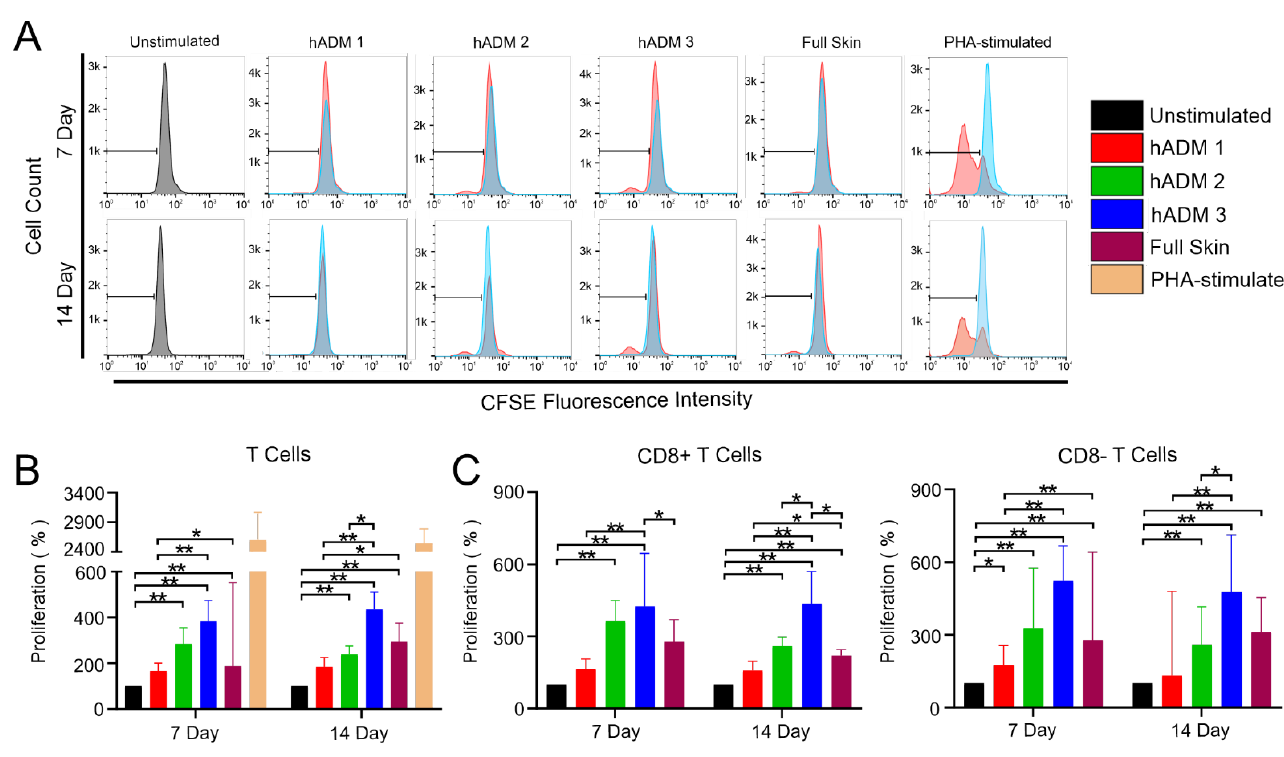
Figure 1. hADM preparation method induces differential T cell proliferation. Flow cytometric analysis of T cell proliferation. CFSE-stained PBMCs were co-incubated alone, with hADMs, with full skin, or with mitogenic control (lectin PHA) for 7 or 14 days. ( A ) Histograms displaying proliferation of whole T cells for 7 and 14 days. ( B ) Quantification of whole CD3+ T cell proliferation. ( C ) Quantification of CD3+/CD8+ and CD3+/CD8 − T cell proliferation. Results expressed as medians + interquartile ranges. Two-tailed Wilcoxon matched-pairs signed-rank test used for ( B , C ). n = 5 with 2 technical replicates; * p < 0.05. ** p < 0.01.